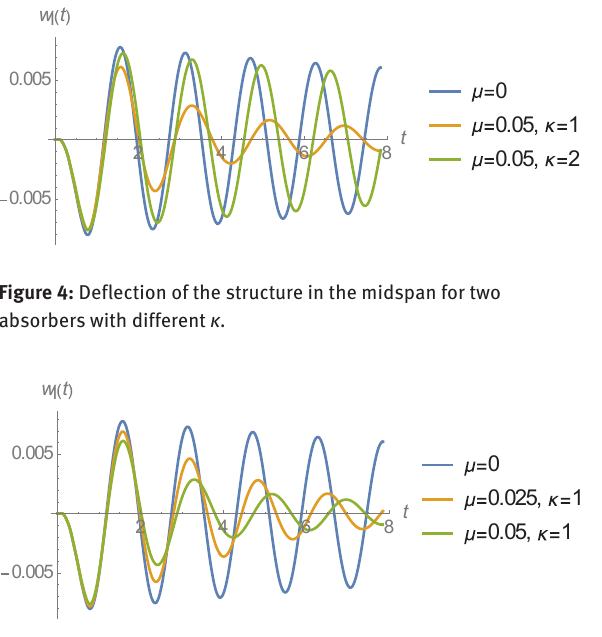
Figure 5: Deflection of the structure in the midspan for two absorbers with different μ .